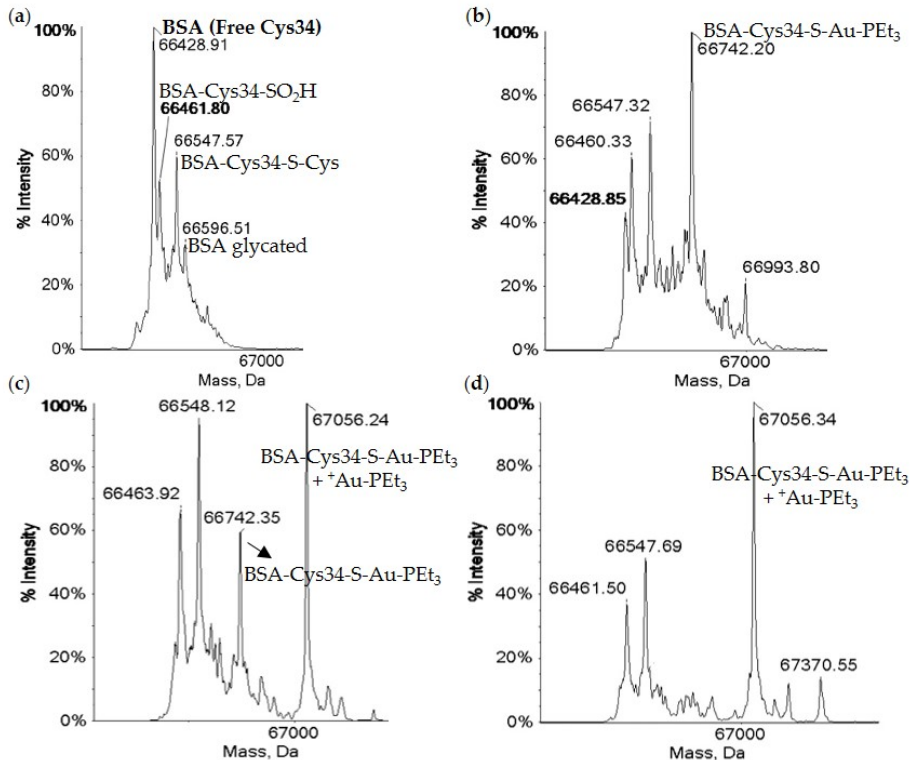
Figure 14. The ESI-MS of metal-free BSA ( a ) and BSA (100 µ M) incubated with AuPEt 3 (CN) ( b ), AuPEt 3 (SCN) ( c ), AuPEt 3 (N 3 ) ( d ) in a 3:1 metal to protein molar ratio after 1 h at pH 6.8 (20 mM NH 4 Acetate) and 37 ◦ C [108]. Note that metal-free BSA consists of several post translational modifications (PTMs) and only the Cys34 with no PTM is able to coordinate directly to Au(I). Also note that the incubation with AF produces an MS spectrum virtually identical to ( b ). Adapted with permission from Pratesi, A.; Cirri, D.; Ciofi, L.; Messori, L. Reactions of auranofin and its pseudohalide derivatives with serum albumin investigated through ESI-Q-TOF MS. Inorg. Chem. 2018 , 57 , 10507–10510. Copyright (2018) American Chemical Society.